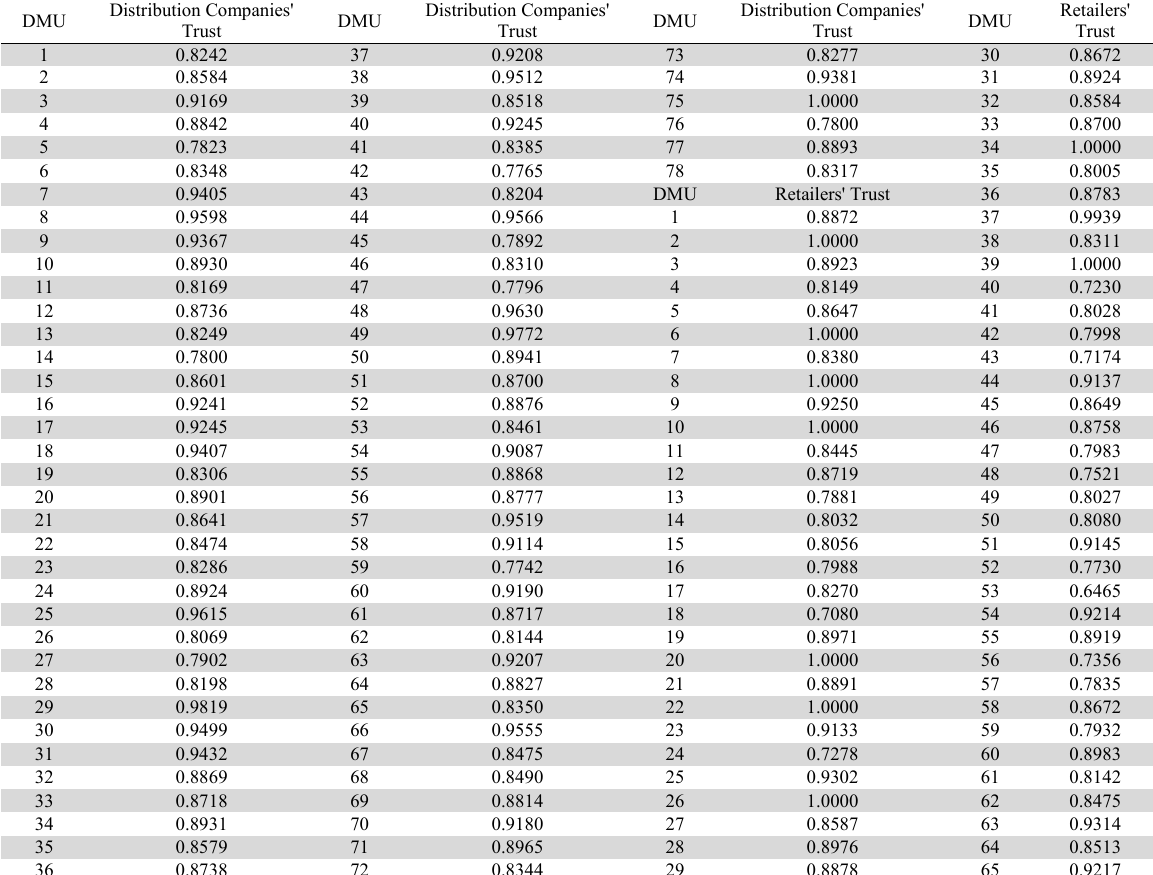
The obtained efficiency scores for both trust models